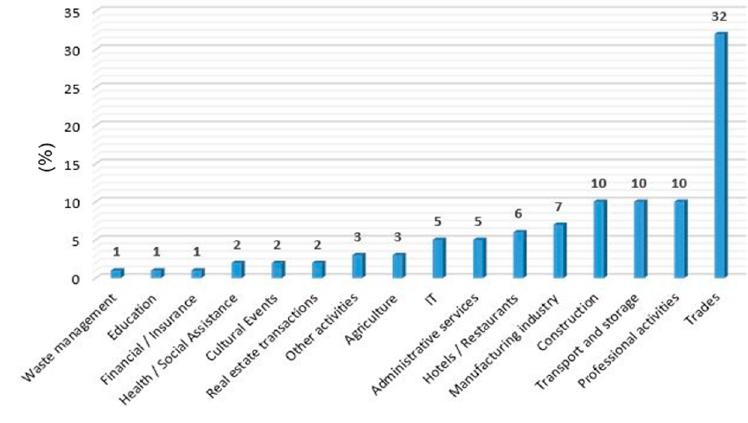
Figure 3. The share of SMEs according to the activity field.